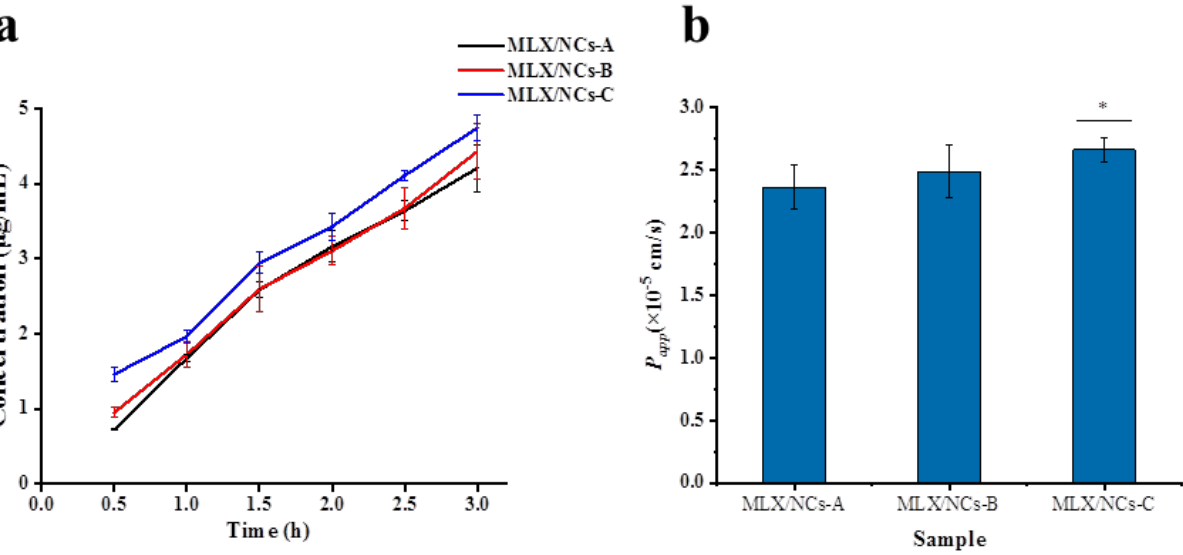
Figure 10. Cumulative amounts and P app of MLX-NCs-A, MLX-NCs-B, and MLX-NCs-C transport across Caco-2 cell monolayers (mean ± SD., n = 4). ( a ) Curve of transport amount over time within 3 h ( b ) the permeability coefficient ( P app ) at 3 h for MLX-NCs-A, MLX-NCs-B, and MLX-NCs-C, * p < 0.05 in comparison to the MLX-NCs-A.